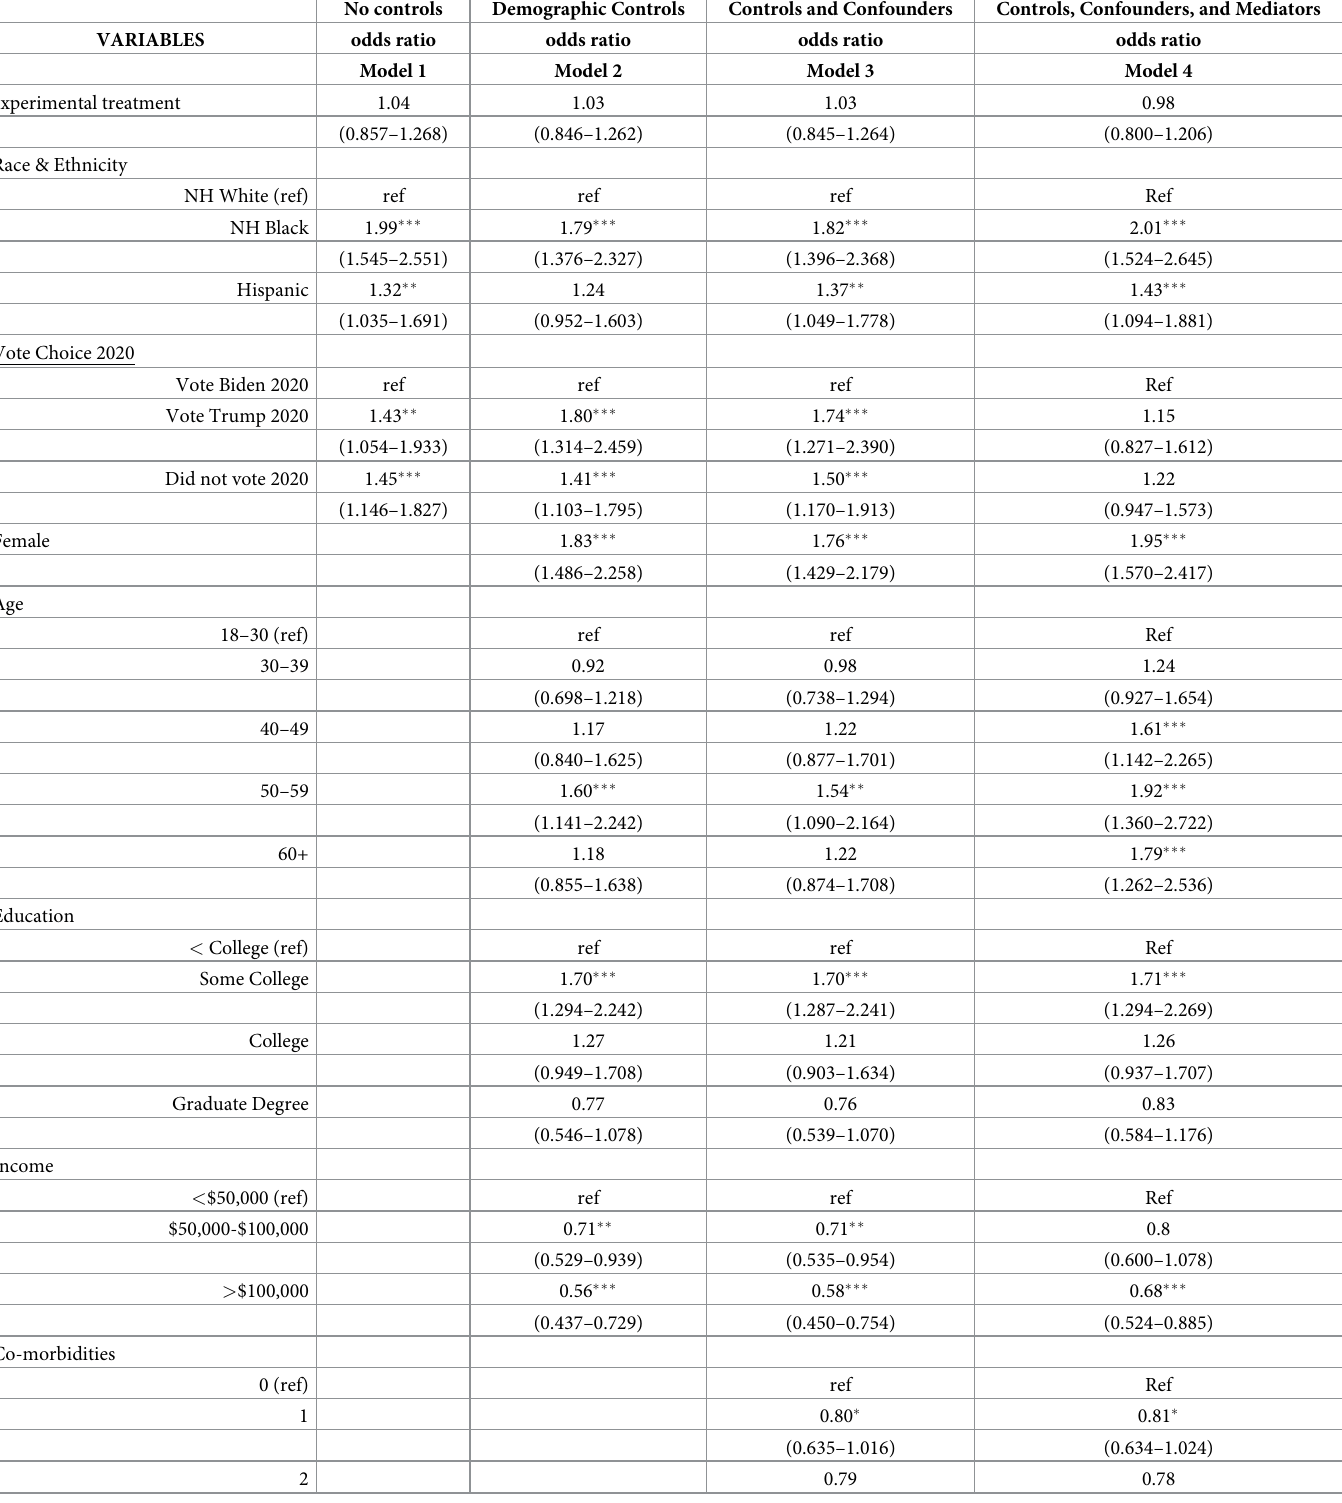
Table 2. Stepwise ordered logistic regression, disparities in vaccine